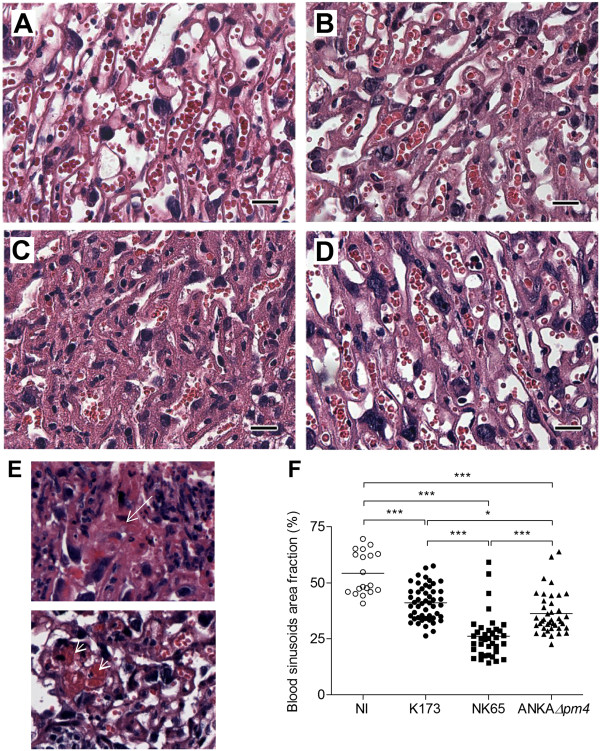
Placental histology of labyrinth zone and morphometric analysis. Representative photomicrograph of H&E stained placental sections of non-infected (NI) (A), K173 (B), NK65 (C) and ANKAΔpm4 infected pregnant mice (D). (E) Histological sections show necrotic foci (arrow) and thrombi (arrowhead) in placentas infected with ANKAΔpm4 (upper picture) and K173 (lower picture) parasites. (F) Relative quantification of vascular space using an automated morphometric procedure in H&E stained sections evaluated in placental sections. Mice were infected i.v. with 106P. berghei K173 or NK65 IE (G13) or ANKAΔpm4 IE (G10); placentas were excised on G18 (K173 and NK65) or G19 (ANKAΔpm4). Scale bar: 20 μm; in (F) line refers to mean; *p<0.05;**p<0.01; ***p<0.001.